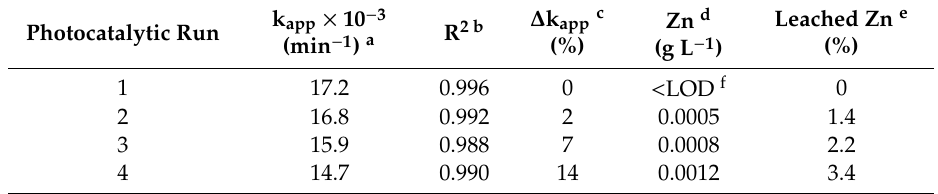
a First-order apparent rate-constant. b Regression factor for k app . c Loss in activity along the consecutive photocatalytic runs. d Zn determined in aqueous phase by atomic absorption spectrometry. e Zn leached after each photocatalytic run with respect to the initial composition of Zn in the catalysts: 0.035 g L − 1 . f Below limit of detection (<LOD).